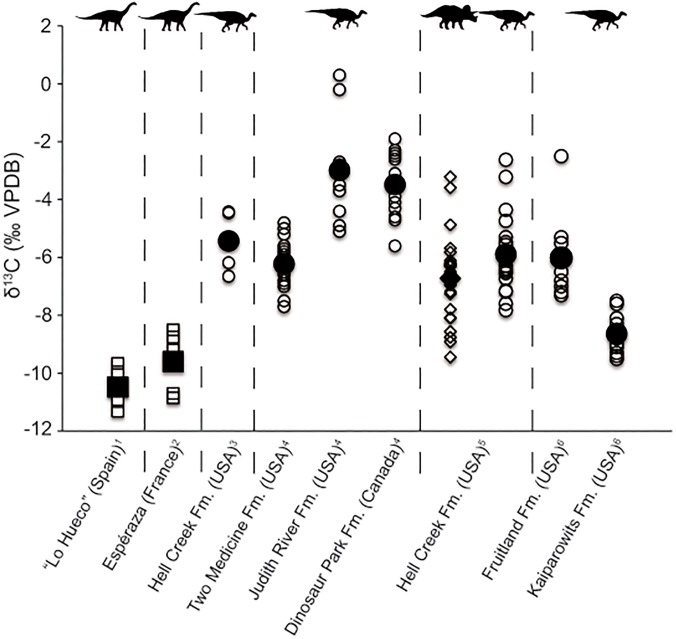
δ13C (‰ VPDB) values for Campanian-Maastrichtian herbivore dinosaurs: titanosaur sauropods (squares), hadrosaurs (circles), and ceratopsians (diamonds).Large black symbols represent mean δ13C values. 1This study; 2Tütken [32]; 3Stanton-Thomas and Carlson [24]; 4Fricke et al. [26]; 5Fricke and Pearson [25]; 6Fricke et al. [53].